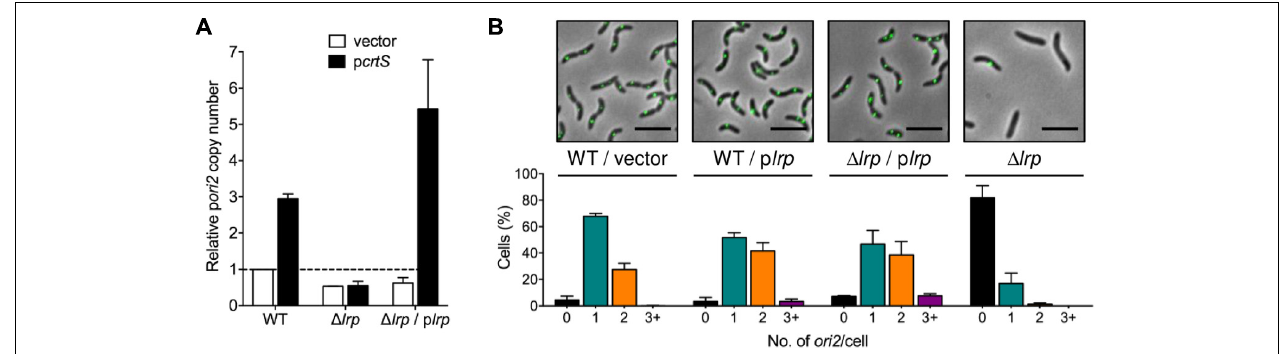
FIGURE 4 | Lrp is necessary for licensing of Chr2 replication by crtS . (A) Copy number of p ori2 (a plasmid carrying the origin of Chr2, pTVC22) in E. coli WT (BR8706), (cid:49) lrp (CVC3260), and (cid:49) lrp/ p lrp (CVC3274/pJWD-2). The cells also contained a source of RctB (pTVC11) and additionally either a vector (white bars) or a crtS -containing plasmid (black bars). The copy numbers were normalized to the value in WT cells, set as 1. p ori2 copy number increases threefold in the presence of p crtS in WT but not in (cid:49) lrp cells. Complementing (cid:49) lrp cells with p lrp increases p ori2 copy number even more that that was seen in WT cells, suggesting that Lrp could be limiting in WT cells. Data represent mean ± SEM from three biological replicates. (B) Histograms of ori2 foci number per cell in WT V. cholerae (CVC3058) with either the vector control (pTrc99A) or p lrp , and in V. cholerae (cid:49) lrp cells (CVC3286) with complementing p lrp and after curing p lrp. Representative microscopy images from each strain are shown above the histograms. Note that the number of cells without any ori2 foci increases in the absence of lrp , indicating that Lrp is crucial for Chr2 replication in V. cholerae . Data represent mean ± SEM from at least 1000 cells imaged from three biological